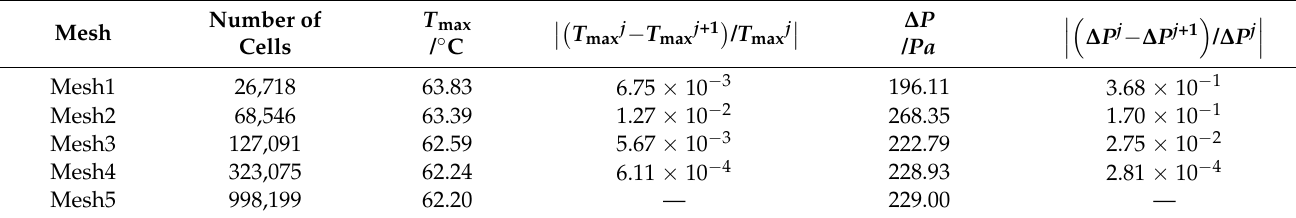
Table 2. Results of the mesh independence test.